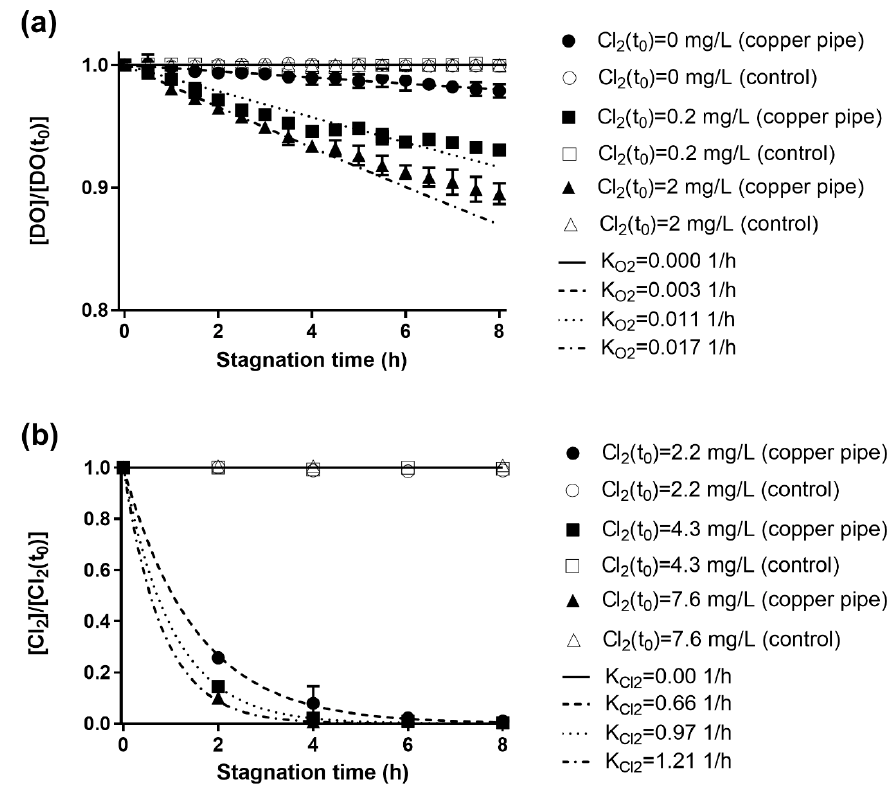
Figure 1. Consumption of dissolved oxygen (DO) and chlorine in new copper pipes during stagnation, the depletion of both oxidizing agents follows a first order kinetics rate law. ( a ) DO consumption during stagnation is significantly a ff ected by the presence of chlorine in the range of concentration expected in drinking water (initial DO was 7.66 ± 0.10 mg / L). ( b ) Chlorine is depleted in about 4 h due to corrosion; no di ff erence was observed in experiments with DO (initial DO was 7.48 ± 0.12 mg / L) and without DO (below detection limit of 0.10 mg / L). The error bars represent the standard deviation (n = 2). The control experiments of copper pipes (glass cylinders) are represented by the same (but empty) symbols.